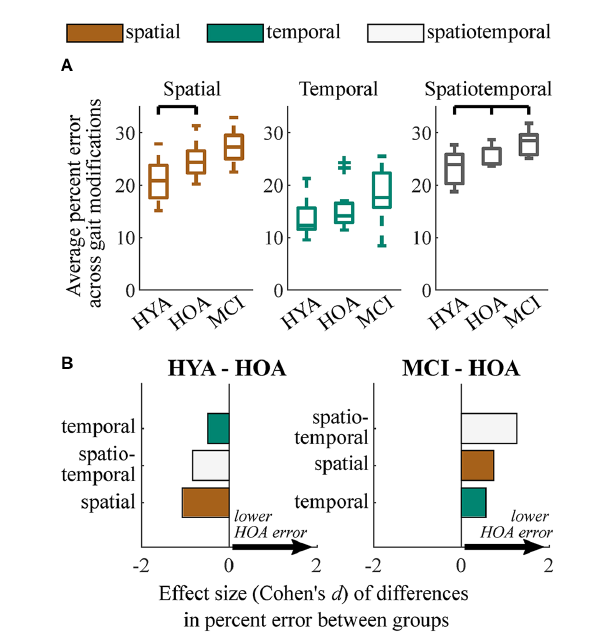
FIGURE3 Summary of group performance on gait modifications. (A) Boxplots showing group performance on spatial, temporal, and spatiotemporal trials. Each sample consists of the average percent error relative to target values across nine gait modifications for spatial and temporal trials and four gait modifications for spatiotemporal trials. (B) Effect sizes of differences in performance (Cohen’s d) between HYA and HOA groups (left) and HOA and MCI groups (right) on spatial (orange), temporal (green), and spatiotemporal (white) gait modifications. Positive values (arrows) imply that the HOA group exhibited lower error on gait modifications. We did not test for differences between the HYA and MCI